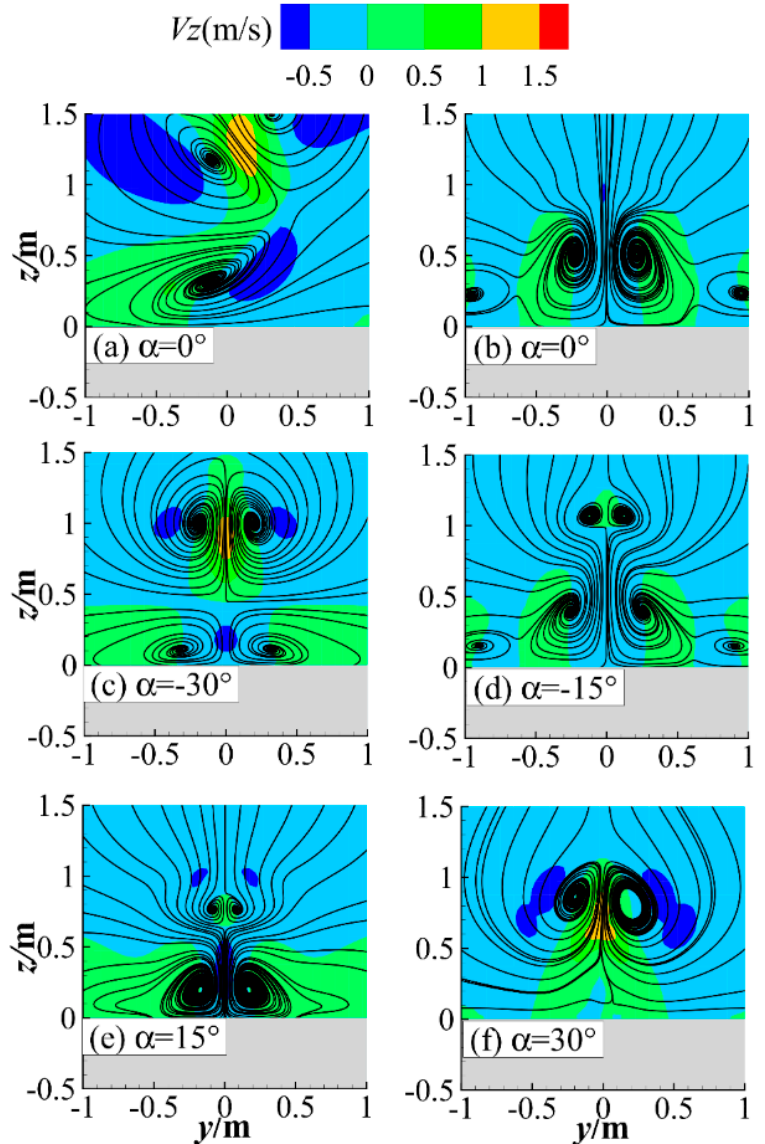
Figure 11. The contour of the Vz and the streamlines behind the cylinder at x = 0.925m at t = 0 s, ( a – f ) represents Case 1 to Case 6 in Table 2, respectively.